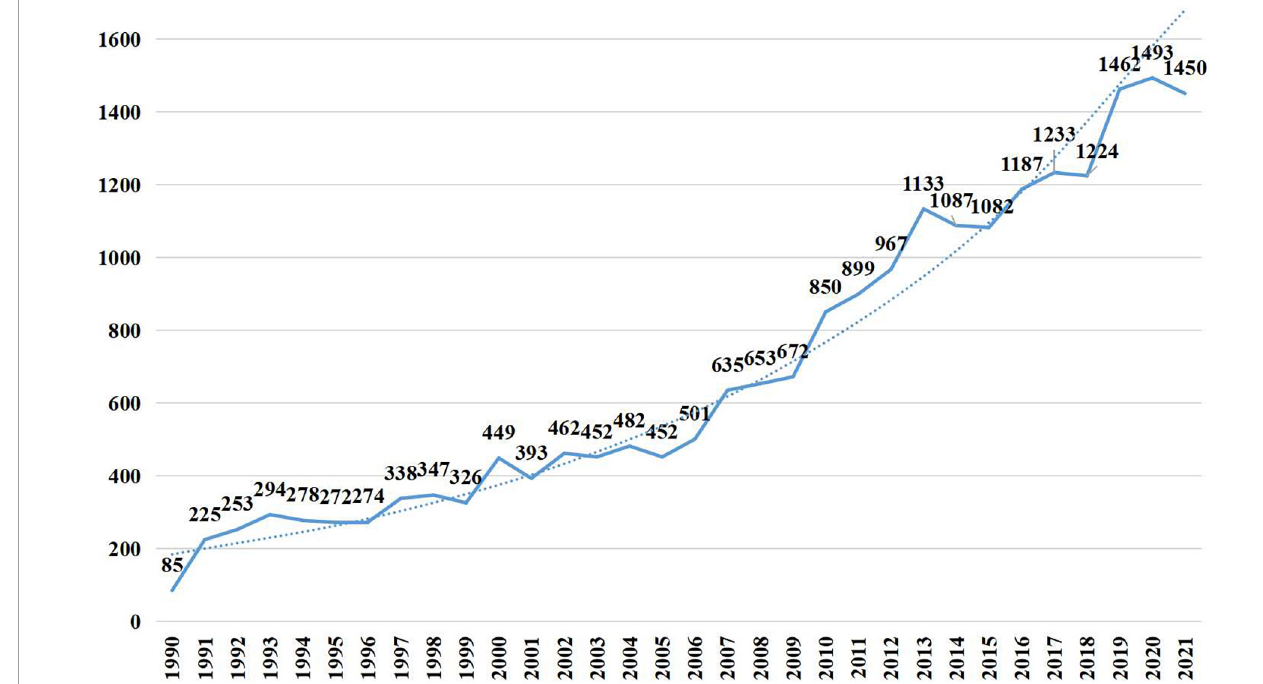
FIGURE1 Articles published per year.